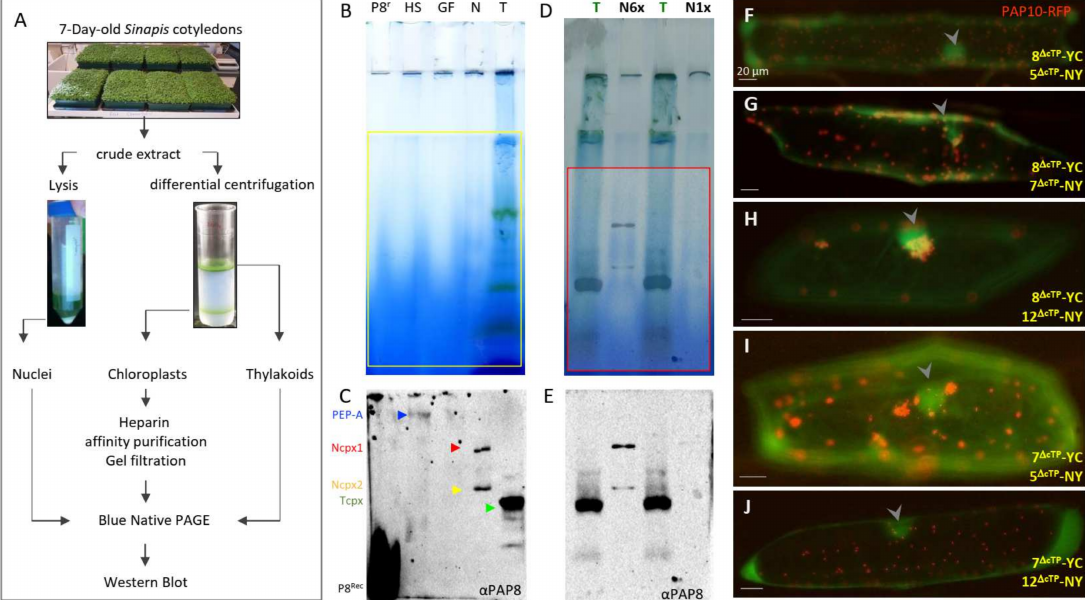
Figure 1. PAP8 is detected within a nuclear subcomplex. ( A ) Organelle fractionation, purification scheme, and sample processing. BN-PAGE, blue native polyacrylamide gel electrophoresis. ( B , D ) BN-PAGE and corresponding Western blot analyses in ( C , E ) using the PAP8 antibody. P8r, recombinant PAP8 protein purified from E. coli ; HS heparin Sepharose fraction produced with the intact chloroplast sample; GF, gel filtration sample following HS; N, N6 × , and N1 × different loading of the sonicated and soluble nuclear fraction (see Section 4). T, thylakoid fraction from broken CP. ( C ) arrowheads, blue for PEP-A, red for the Ncpx1 (large nuclear complex), yellow Ncpx2 (smaller complex), green for the thylakoid PAP8-containing complex, and α PAP8 for the primary anti-PAP8 antibody. ( F – J ) Bimolecular fluo- rescence complementation tests using in combination PAP8 ∆ cTP -YC (8 ∆ cTP -YC) with PAP5 ∆ cTP -NY (5 ∆ cTP -NY) in ( F ); 8 ∆ cTP -YC with PAP7 ∆ cTP -NY (7 ∆ cTP-NY) in ( G ); 8 ∆ cTP -YC with PAP12 ∆ cTP -NY (12 ∆ cTP -NY) in ( H ); 7 ∆ cTP -YC 5 ∆ cTP -NY) in ( I ) and 7 ∆ cTP -YC with (12 ∆ cTP -NY) in ( J ); PAP10-RFP was used as internal positive control for transfection. Arrowheads indicate nuclei. Transgenes expressed under CaMV35S promoter (see [27] for published control experiments). Scale bars equal 20 µ